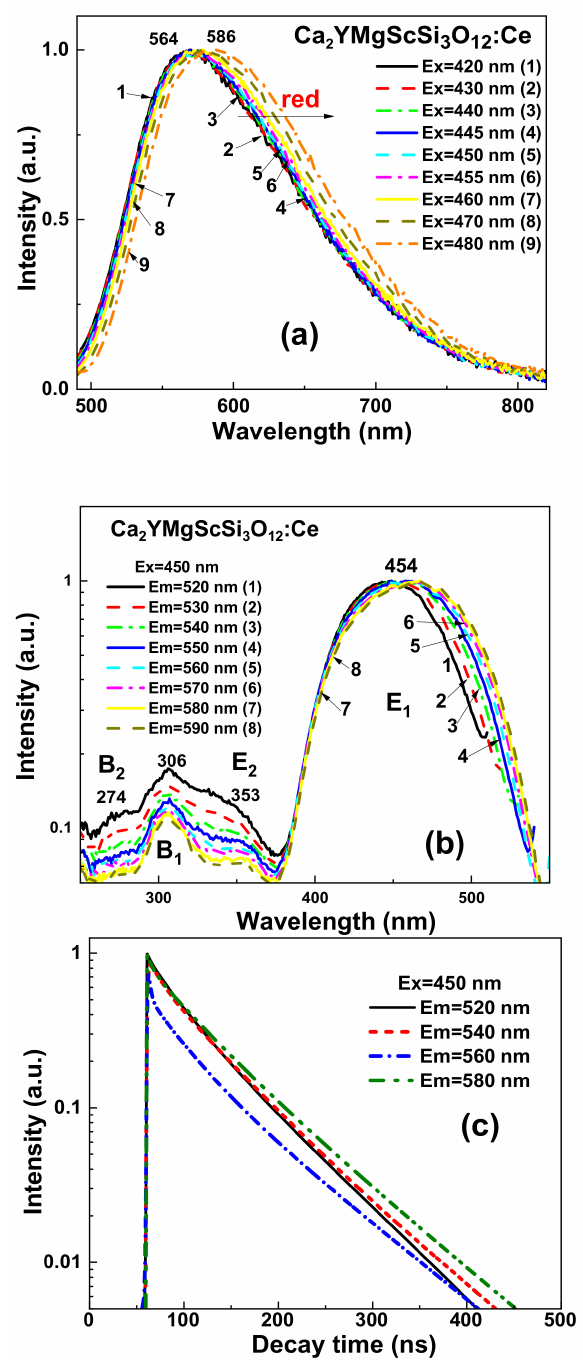
Figure 7. Detailed luminescent properties of Ca 2 YMgScSi 3 O 12 :Ce5% MPs at RT. Emission ( a ) and excitation ( b ) recorded in different parts of the respective spectra. PL decay kinetics ( c ) at RT recorded under blue light (450 nm) excitation in different parts of the Ce 3+ emission